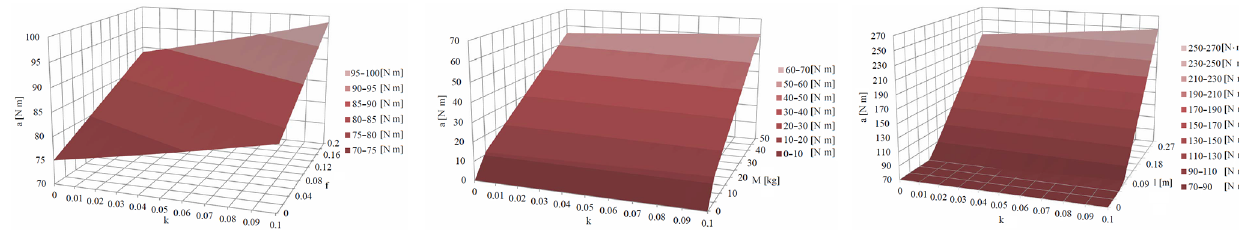
Figure 28. Boundaries of the excitation region of the rotational movement of the driving link (engine shaft).